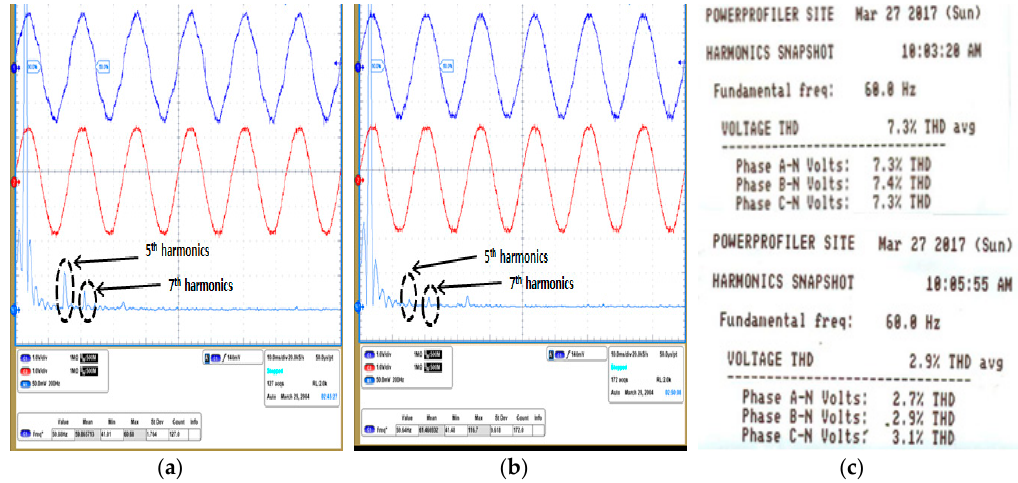
Figure 19. Experimental results: ( a ) without harmonic compensation; ( b ) with harmonic compensation, (From top to bottom: measured a -phase inverter output voltage and grid voltage, and FFT of the inverter output voltage); and ( c ) THD analyses.